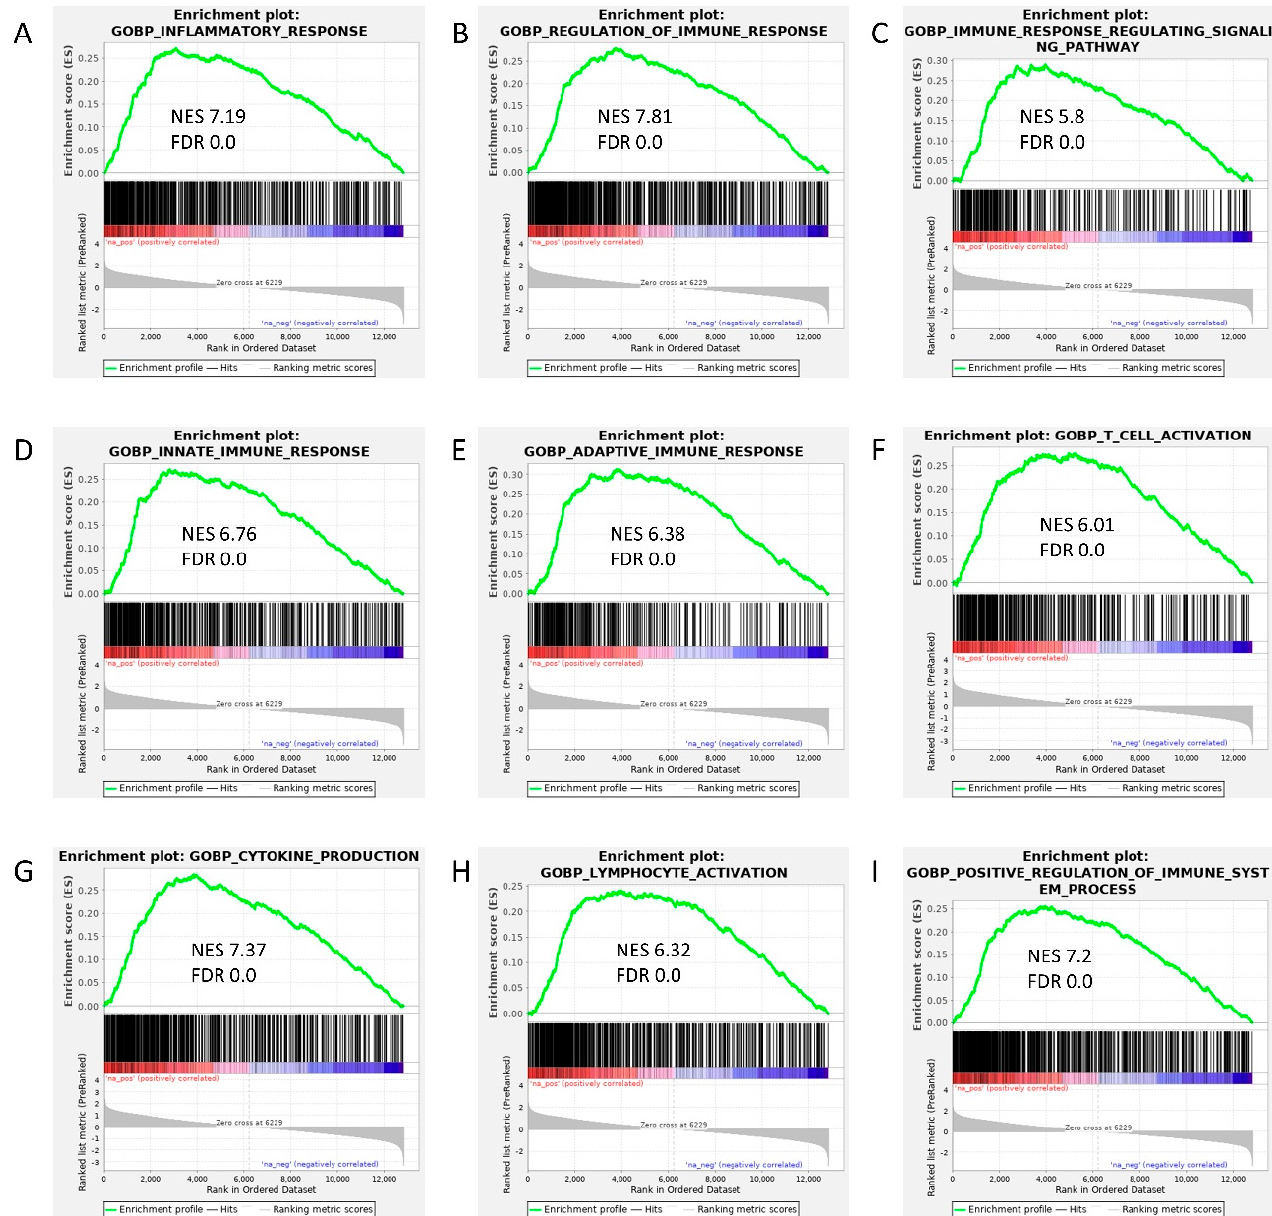
Figure 3. Gene Set Enrichment Analysis (GSEA) in the SBH/y model of cerebral small vessel disease (CSVD). GSEA of differential expression between SBH/y- DS ( n = 4) and SBH/y sham ( n = 4) demon- strates that the following gene sets were upregulated in our model: inflammatory response ( A ), regulation of immune response ( B ), immune response regulating signaling pathway ( C ), innate ( D ) and adaptive ( E ) immune response, T cell activation ( F ), cytokine production ( G ), lymphocyte activa- tion ( H ), and positive regulation of immune system process ( I ). Green curves show the accumulating enrichment score. Normalized enrichment score (NES) and false discovery ratio (FDR) are shown for each gene set